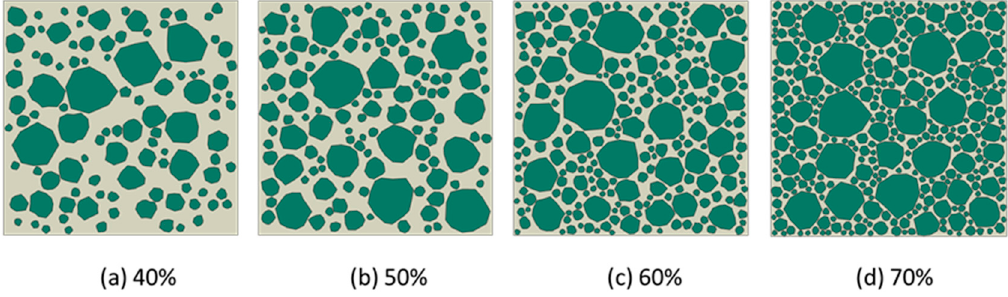
Figure 12. Irregular stone concrete models under different aggregate volume fractions with the scale factor between long and short axes, f = 1. ( a ) 40%; ( b ) 50%;( c ) 60%;( d ) 70%.